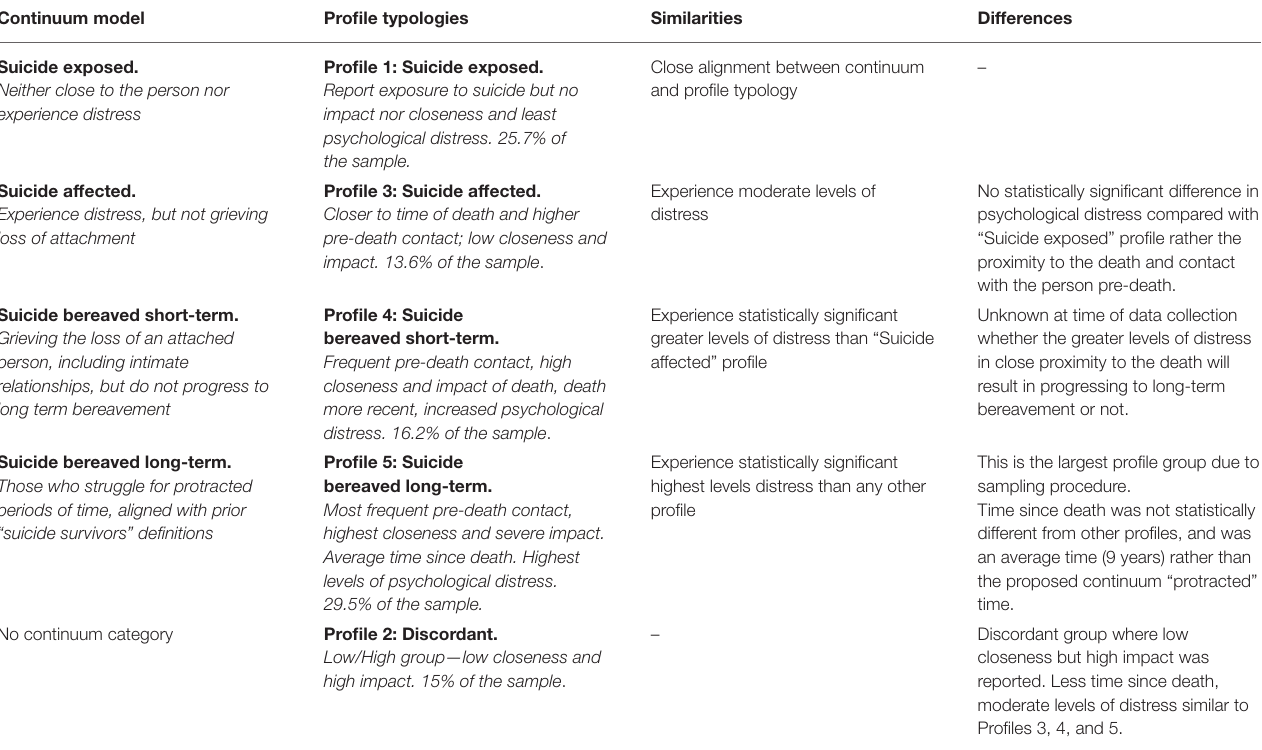
TABLE 4 | Matching the Continuum of Survivorship with profile